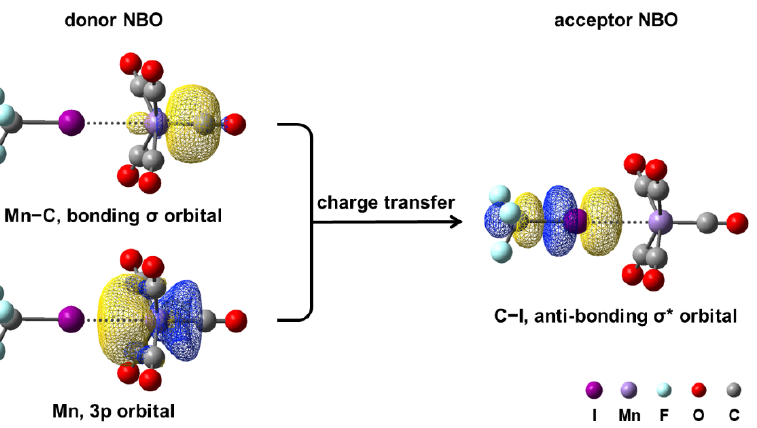
Figure 4. Donor and acceptor natural bond orbitals (NBOs) of halogen-bonded